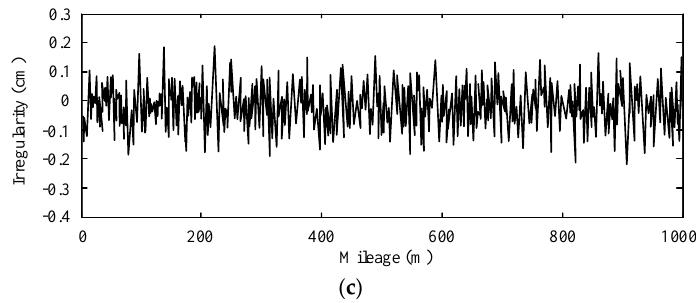
Figure 4. The track irregularity spectrum of the track beam: ( a ) under the traveling wheel; ( b ) under the steering wheel; ( c ) under the stabilizing wheel.